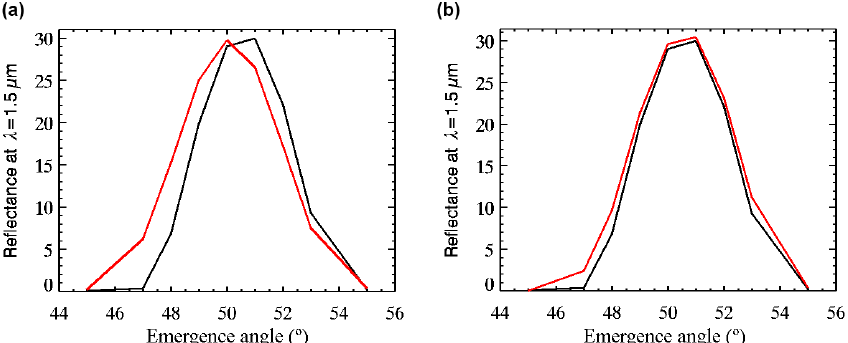
Figure 7. (a) Measured (black) and simulated (red) reflectance factor at 1 . 5µm in the principal plane for an incidence angle of 50 ◦ . The specular lobe measured is not centered at 50 ◦ . (b) Measured (black) and simulated (red) reflectance factor at 1 . 5µm in the principal plane for an incidence angle of 50 ◦ . We simulated a small misadjustment of the sample, resulting in a shift of the observation of 0 . 5 ◦ in emergence and 0 . 2 ◦ in